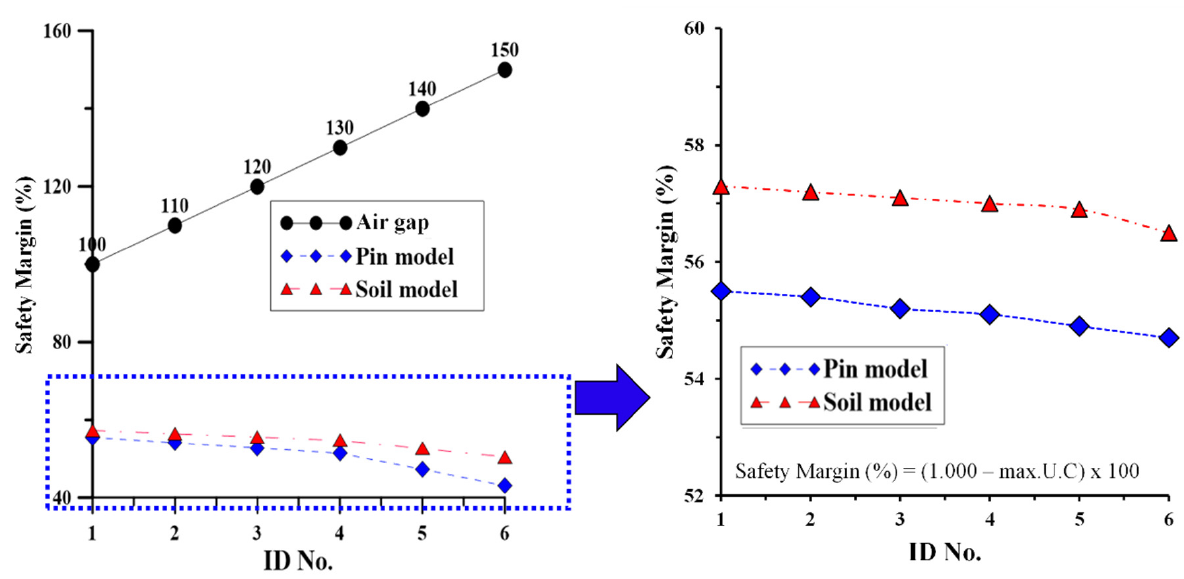
Figure 12. Comparative unit check margin with varying air gap .